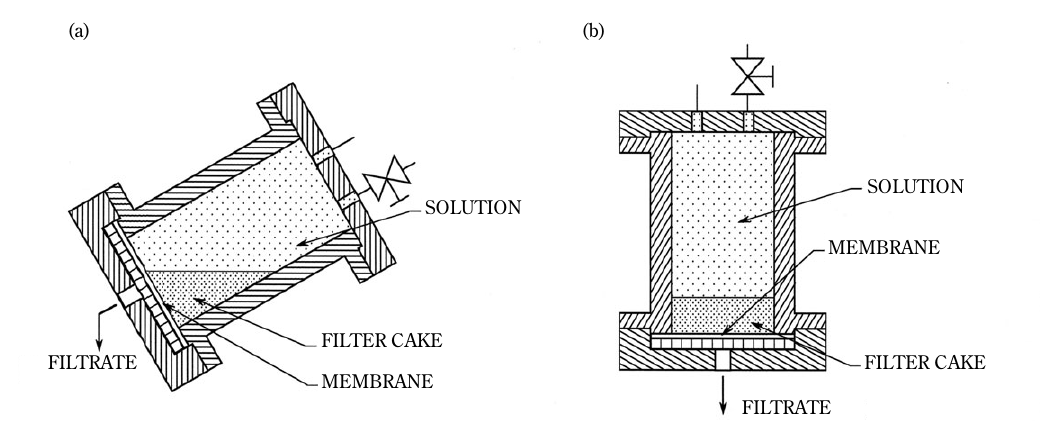
Fig. 12 Schematic diagram of flowing filter cake: (a) inclined ultrafiltration, and (b) downward